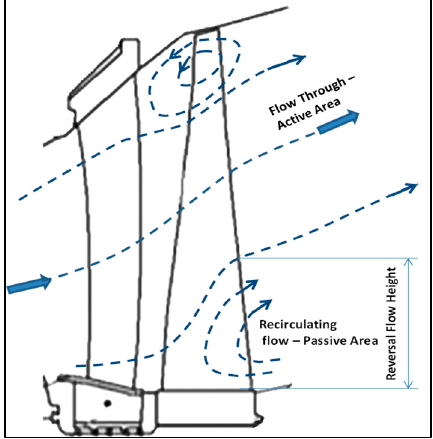
Figure 1. Schematic representation of flow-reversal phenomenon [12].